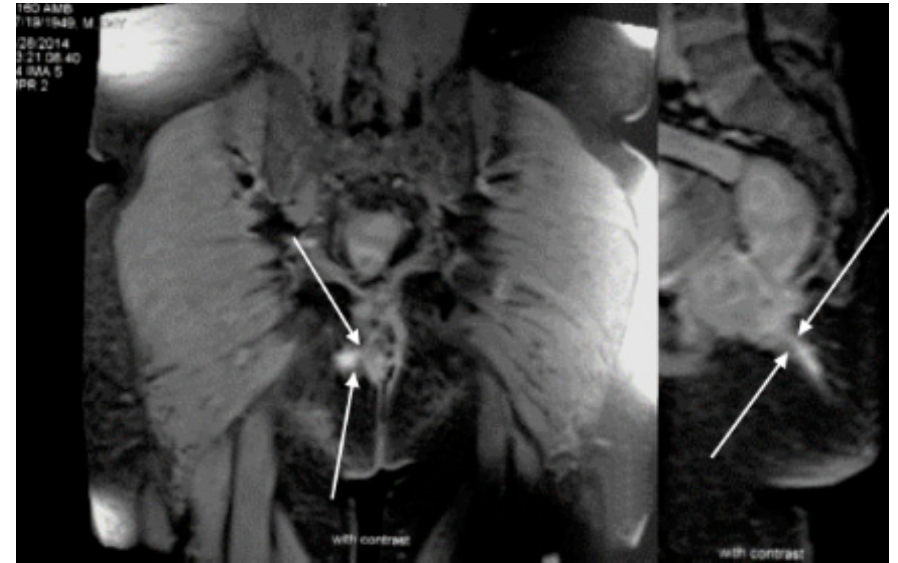
Figure 1. Pelvic MR: Arrows show complicated, branching perianal cutaneous fistula.